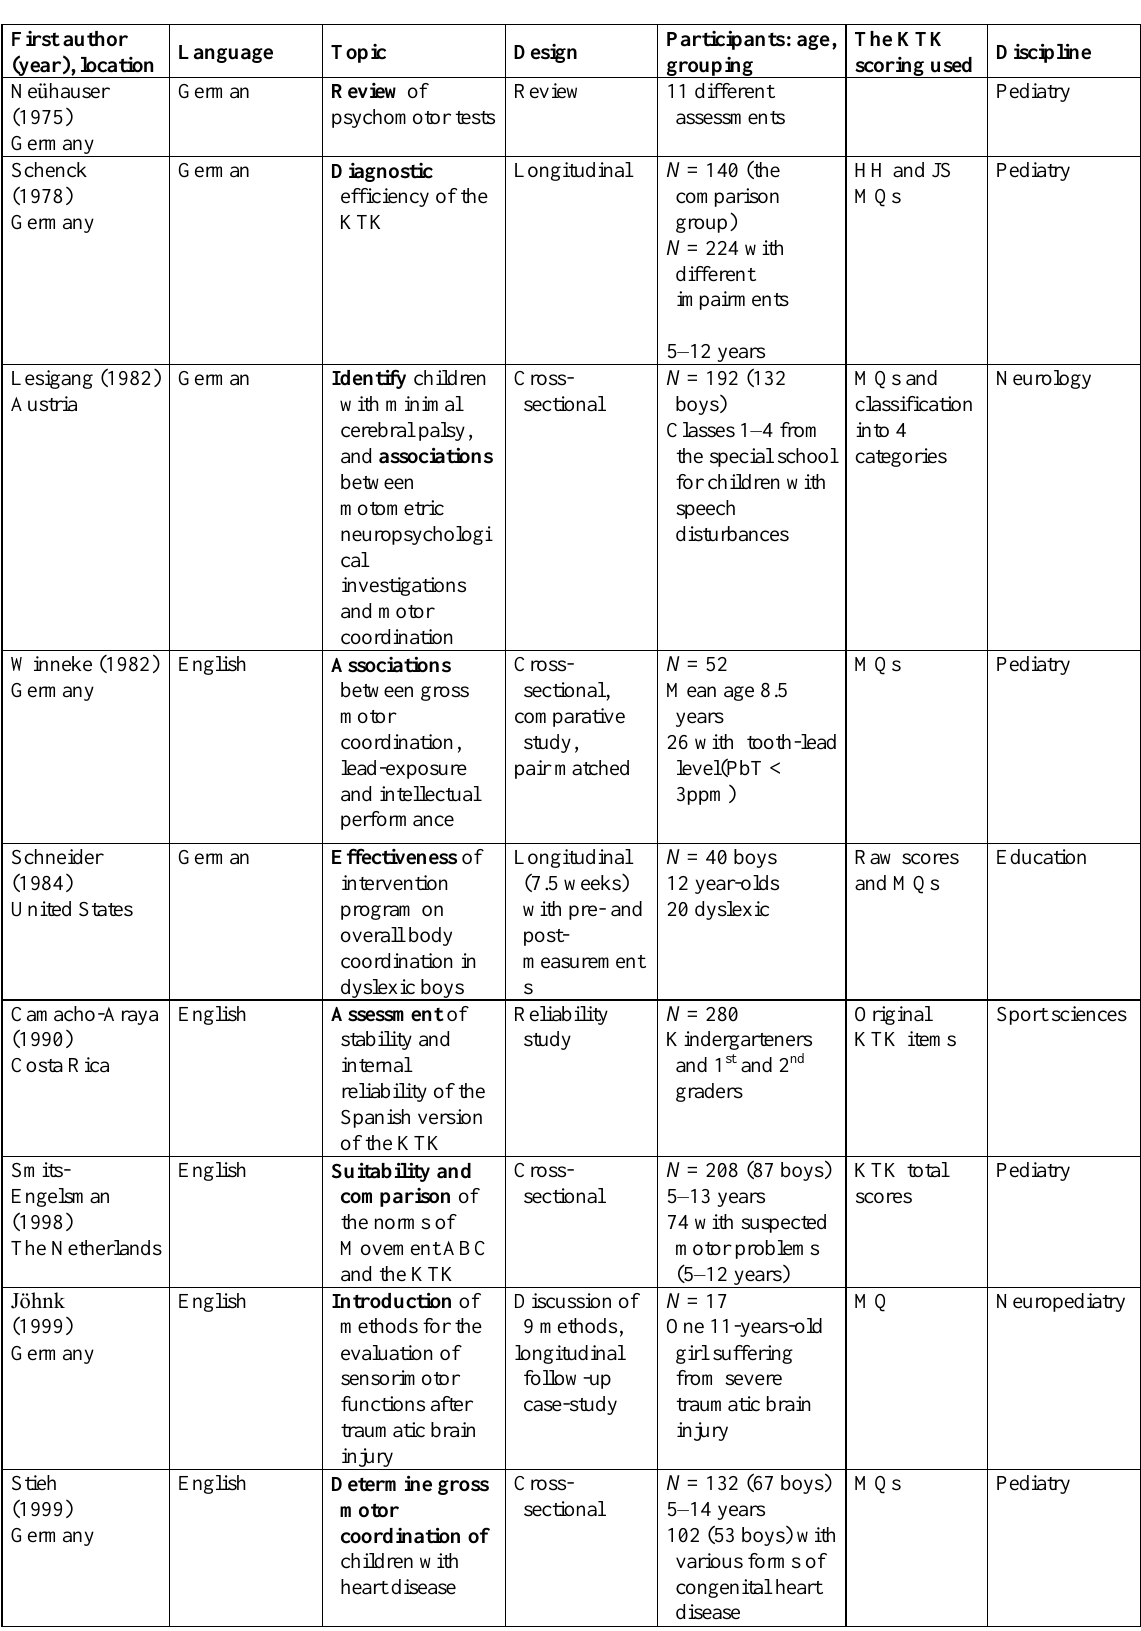
Table 1. Summary of the included